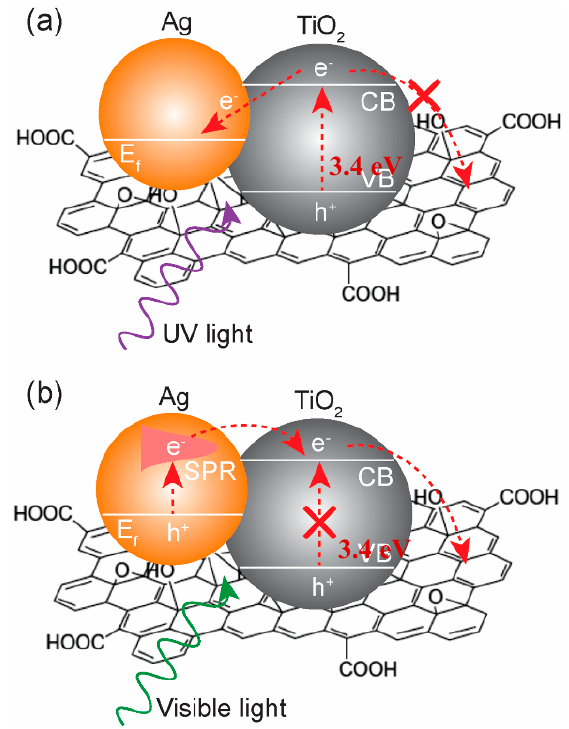
Figure 6. Schematic representation of possible electron transfer paths in Ag/TiO 2 /GO nanocomposites under ( a ) UV and ( b ) visible light excitation.